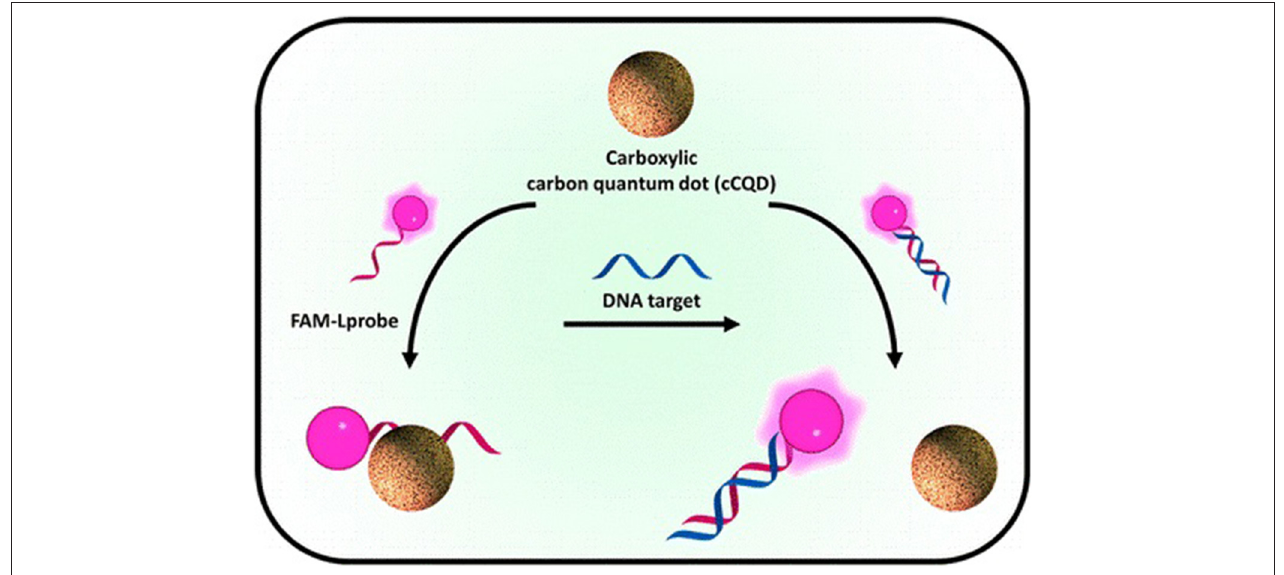
FIGURE 3 | Fluorescent detection of DNA by Carboxylic acid quantum dots. Reprinted with permission from Loo et al. (2016). © (2016) American Chemical Society.